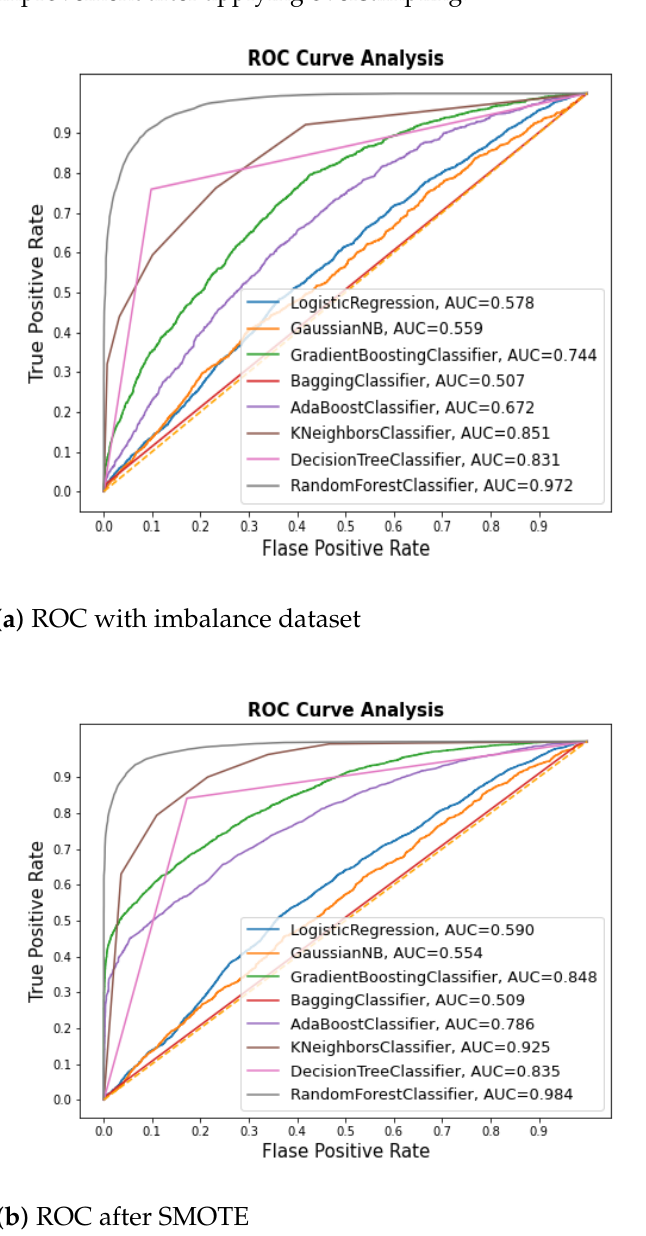
Figure 10. ROC for classifiers with imbalance and SMOTE balance power system dataset Figure 9. ROC for classifiers with imbalance and SMOTE balance power system